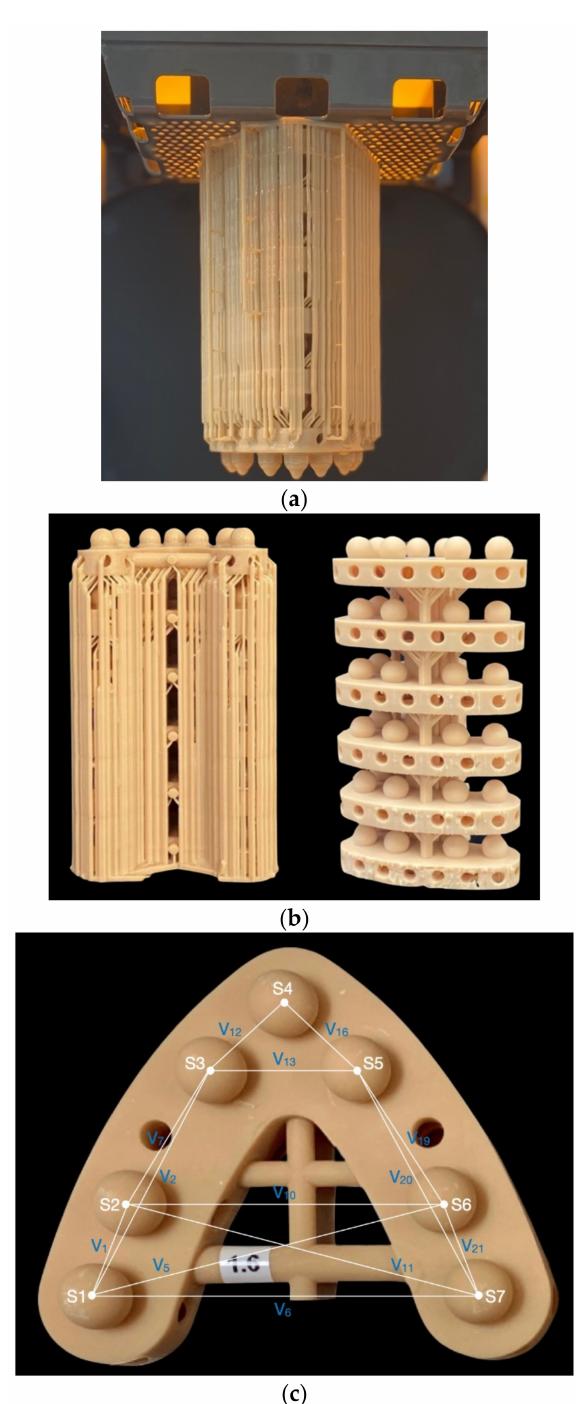
Figure 1. ( a ) Six-tier stacked models with support structures centred on the build plate.( b ) demon- strates the design of each model with struts and holes for support to minimise warpage. ( c ) shows the anterior and posterior connection bar, with spheres (S), and a representation of the vectors (V) extending between the spheres’ centre to measure full arch and arch-segment accuracy. The accuracy of the anteroposterior arch segment was measured through vector 3 (V 3 ), extended between sphere 1 (S1) and sphere 4 (S4), and V 18 , extended between S4 and